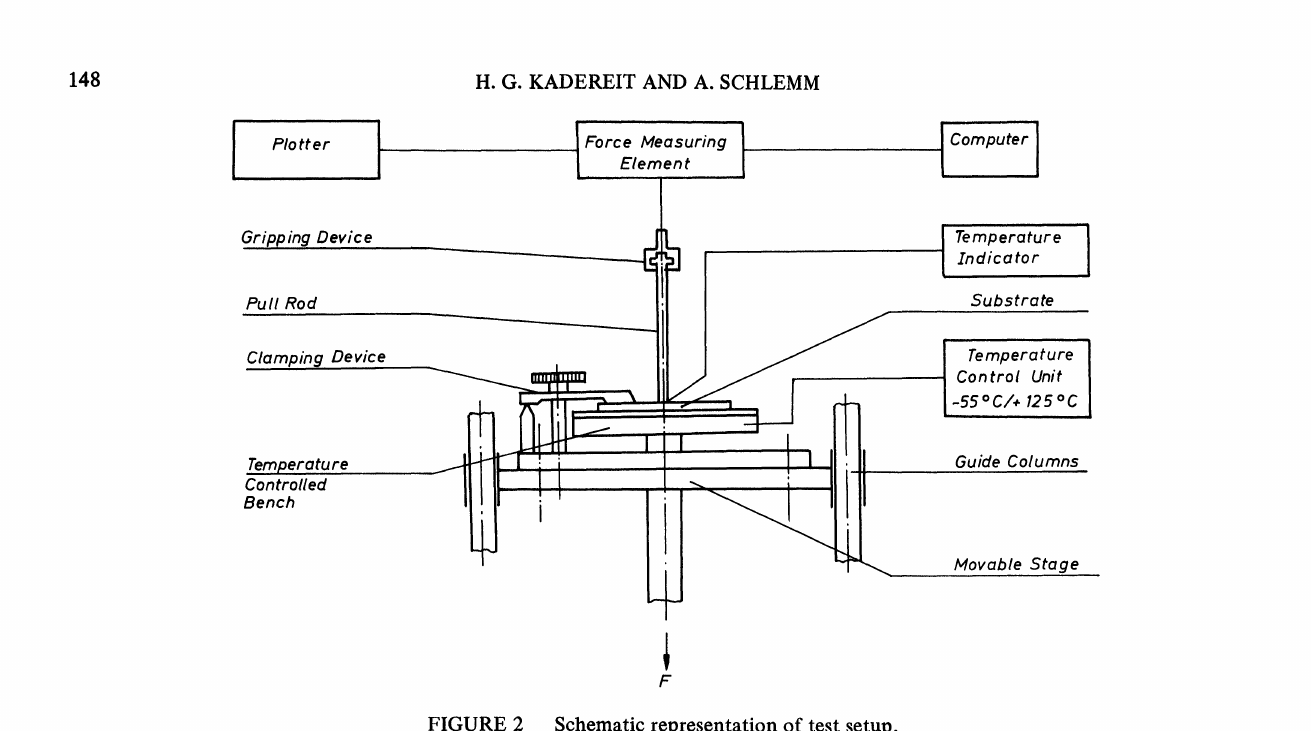
FIGURE 2 Schematic representation of test